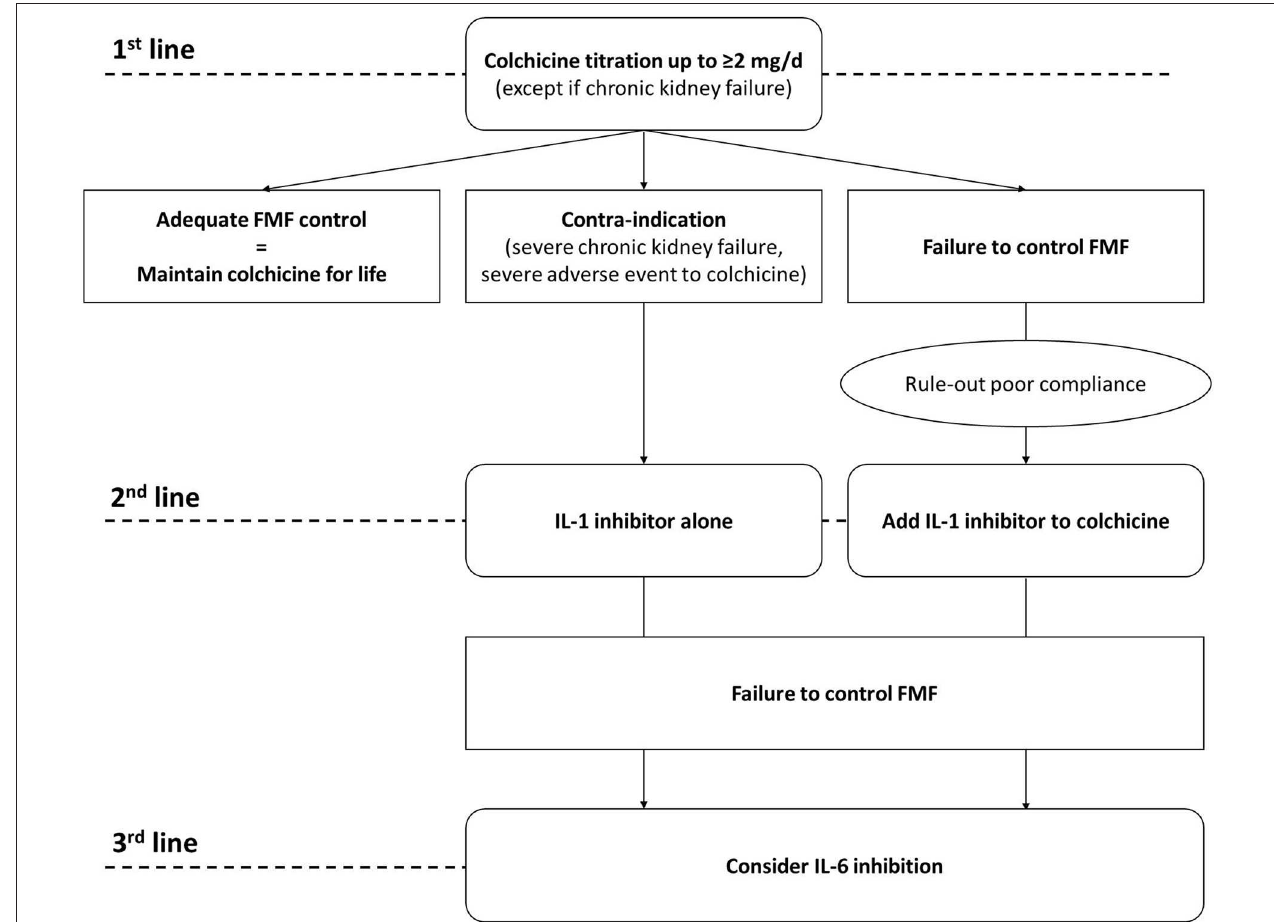
FIGURE 1 | Proposal of a therapeutic algorithm for AA amyloidosis in patients with